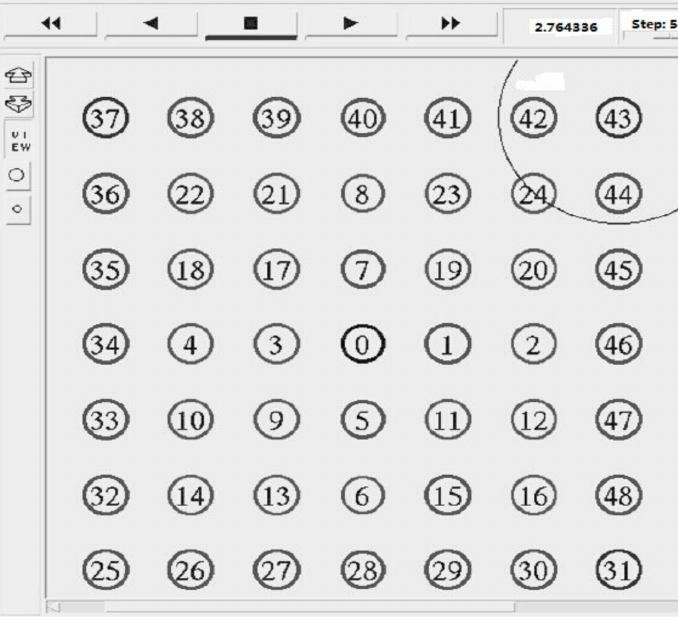
Figure 1. Simulation